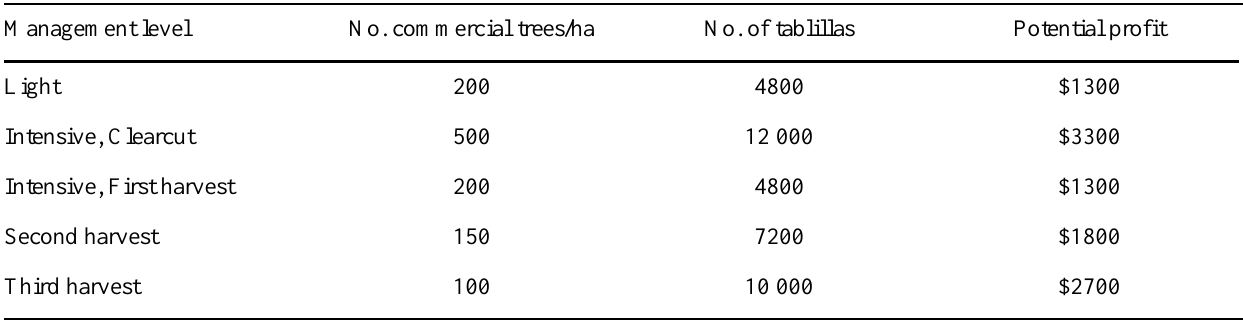
Table 3. Potential tablilla production and profits to the farmer from 1 ha of managed fallow, assuming 25 cm dbh commercial diameter, according to management intensity and harvest